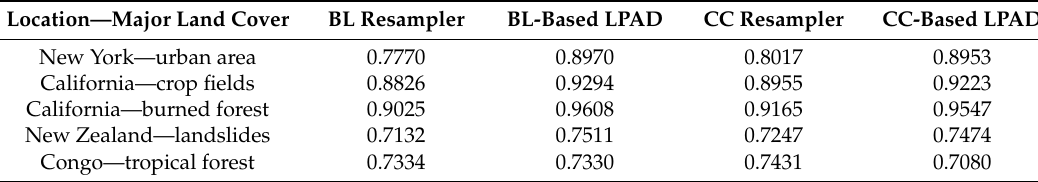
Table 3. Q 2 n values comparing the Sentinel-2A 20-m data with the conventional bilinear (BL), BL-based LPAD, conventional cubic convolution (CC), and CC-based LPAD Landsat-8 20-m data. Results for the true color reflectance (red, green, blue) bands (Table 1) and the image areas illustrated in Figures 4a, 5a, 6a, 7a and 8a.